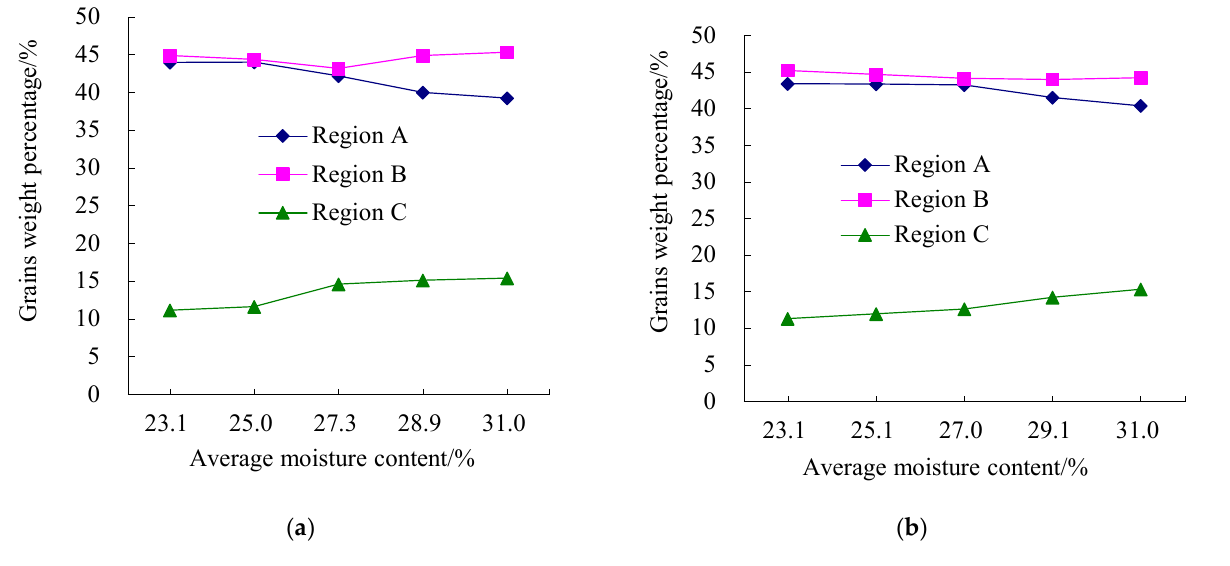
Figure 9. The relationship between threshing grain amount and moisture content in each section. ( a ) TD1; ( b ) TD2.